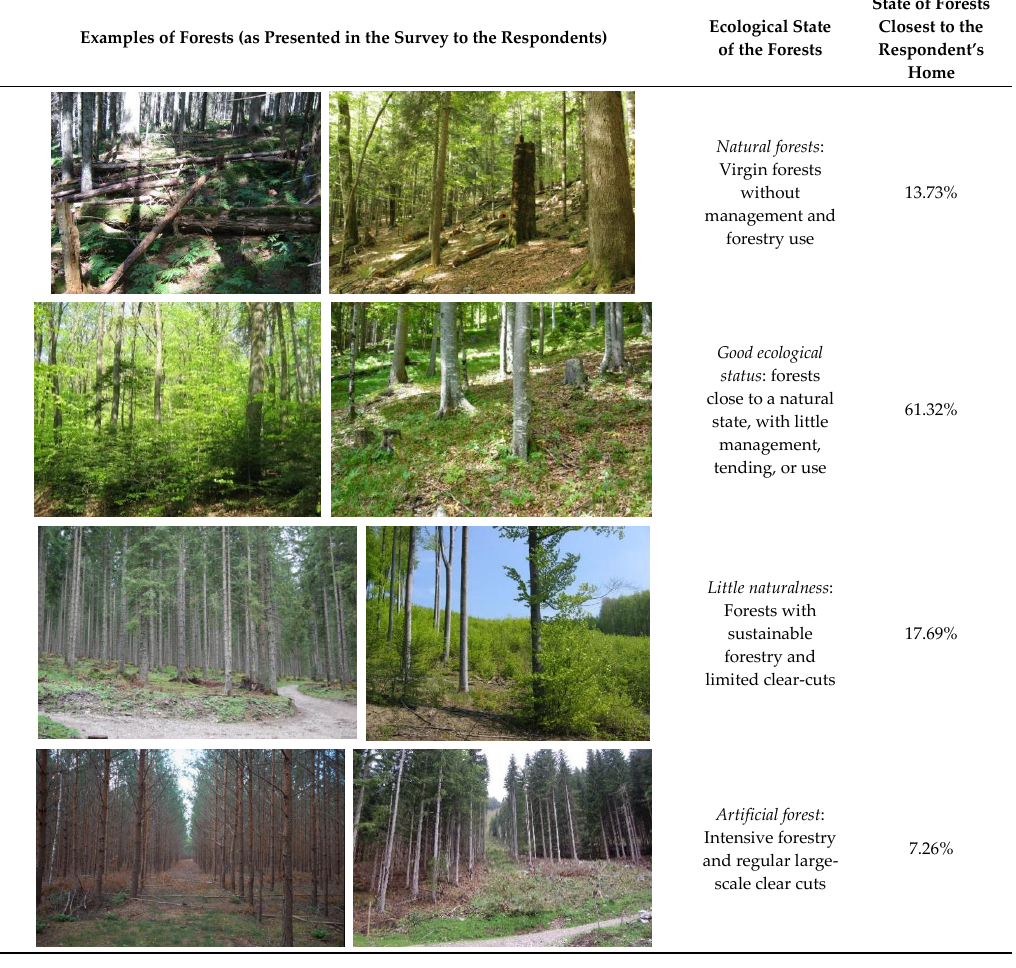
Figure 1. Visualization of the different ecological states of forests.